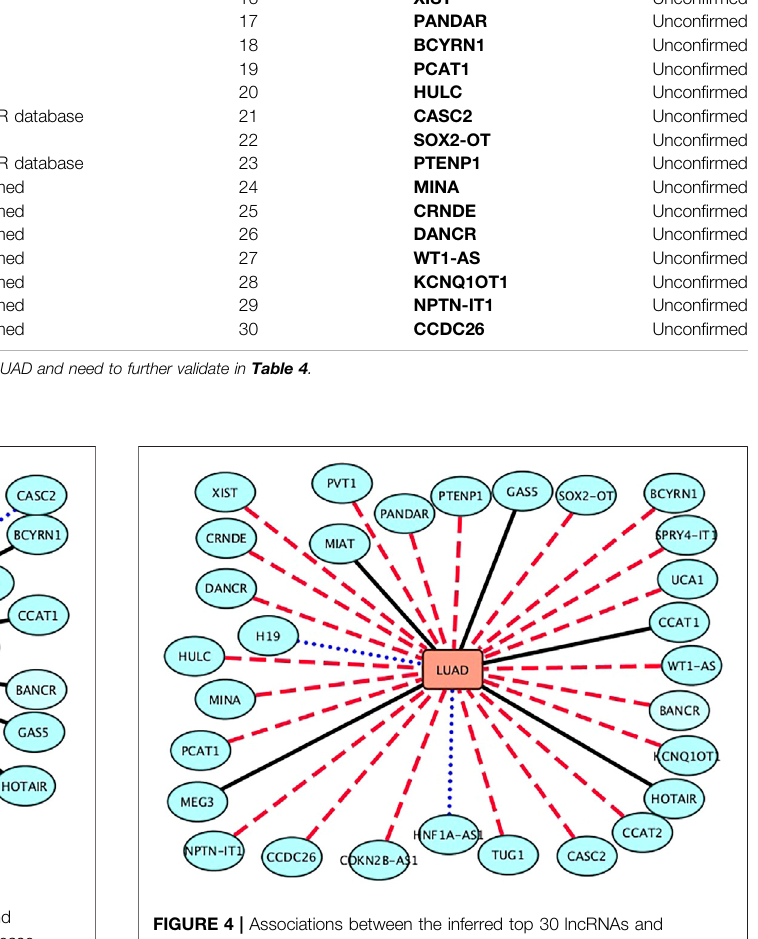
FIGURE 4 | Associations between the inferred top 30 lncRNAs and LUAD. Black solid lines represent known LDAs in the lncRNADisease database. Blue-dot lines represent LDAs that can be observed in the MNDR database. Red-dash lines represent LDAs predicted to be potential lncRNA biomarkers of adenocarcinoma of